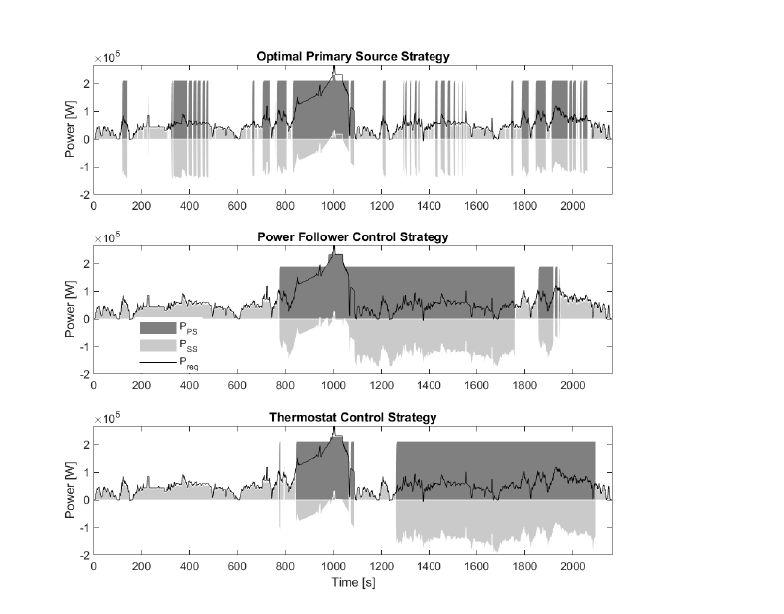
Figure 4 – Power time histories of the tested EMS Рис. 4 − Профиль изменения мощности протестированных стратегий управления энергопотреблением